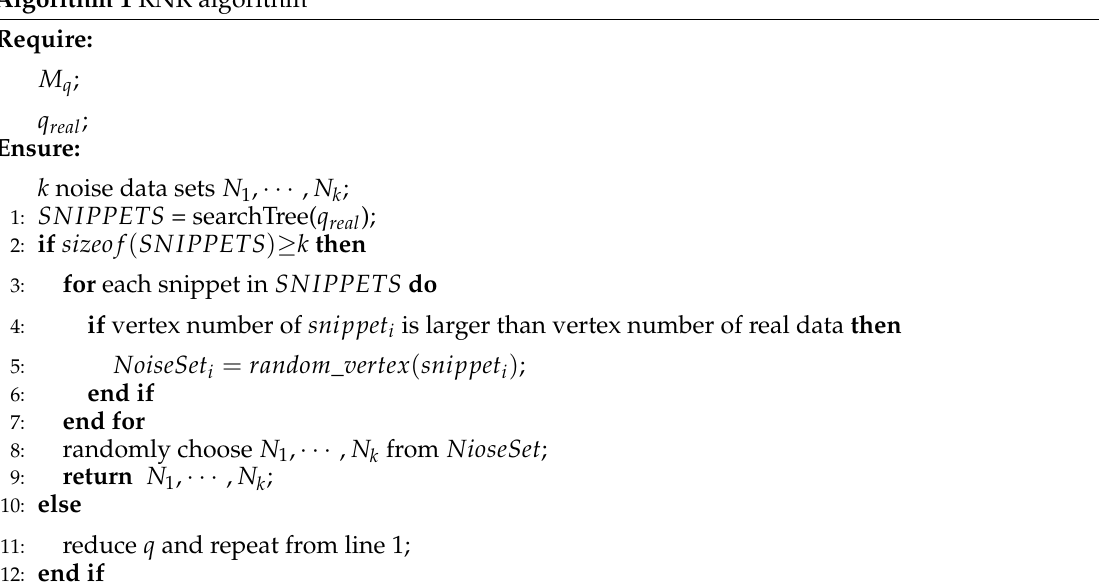
Algorithm 1 RNR